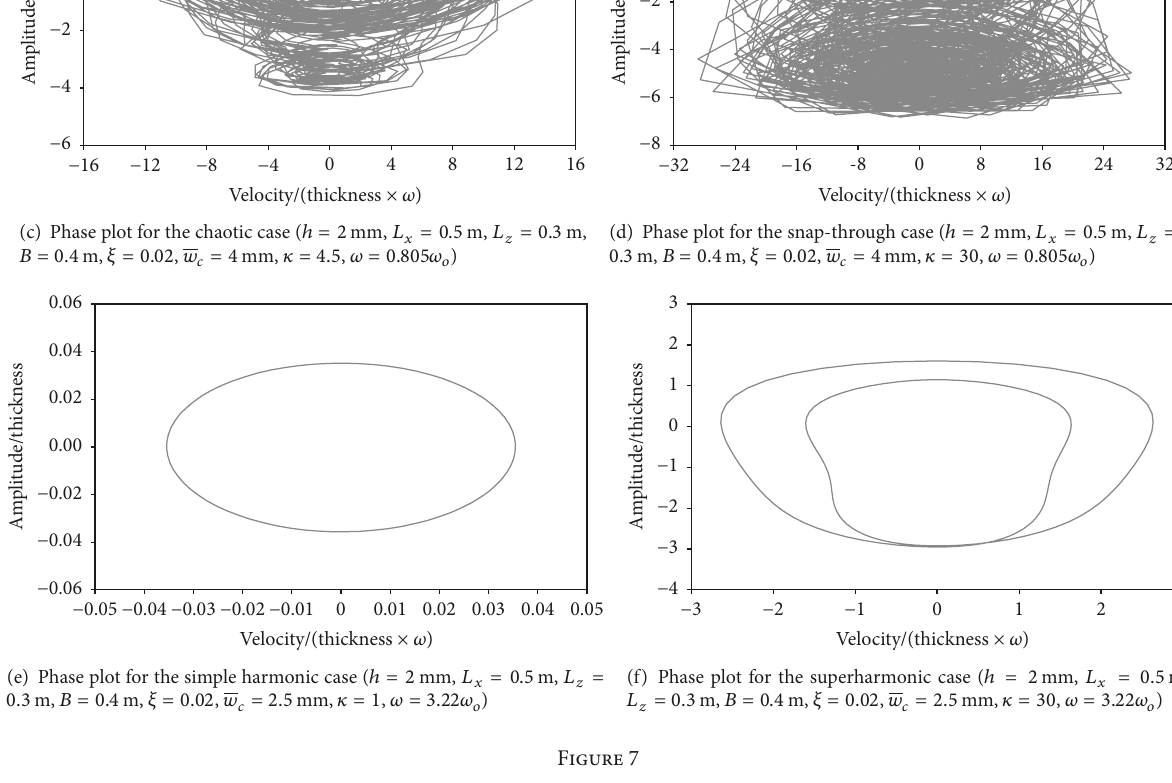
(f) Phase plot for the superharmonic case ( ℎ = 2 mm, 𝐿 𝑥 = 0.5 m,